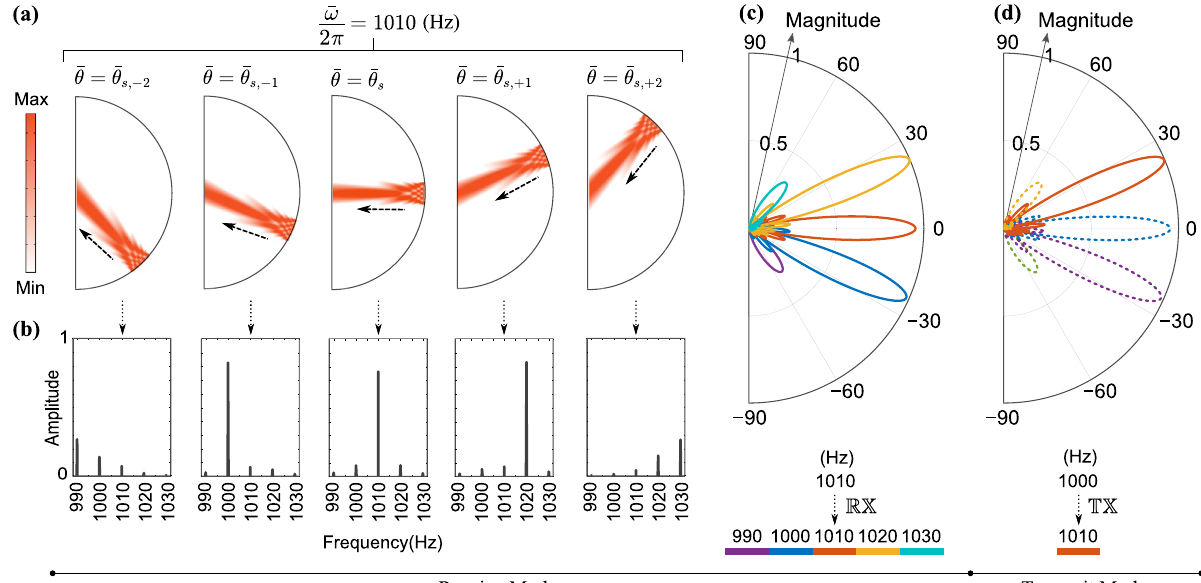
Figure 10. Time-domain finite element simulations of the STP phased array in RX mode for a modulation 1010 Hz incident upon the array from (left to right): 1.5 . ( a ) Plane wave at ¯ ω depth of δ 2 π = = 0 23 23 55 θ s , 1 1 2 ◦ , ¯ θ s , ◦ , ¯ θ s = ◦ and ¯ θ s , ◦ . ( b ) Normalized FFT of the collected voltage signal ¯ = − = = − + + amplitude for each case in ( a ). ( c ) Radiation pattern in RX mode for the different listening channels. ( d